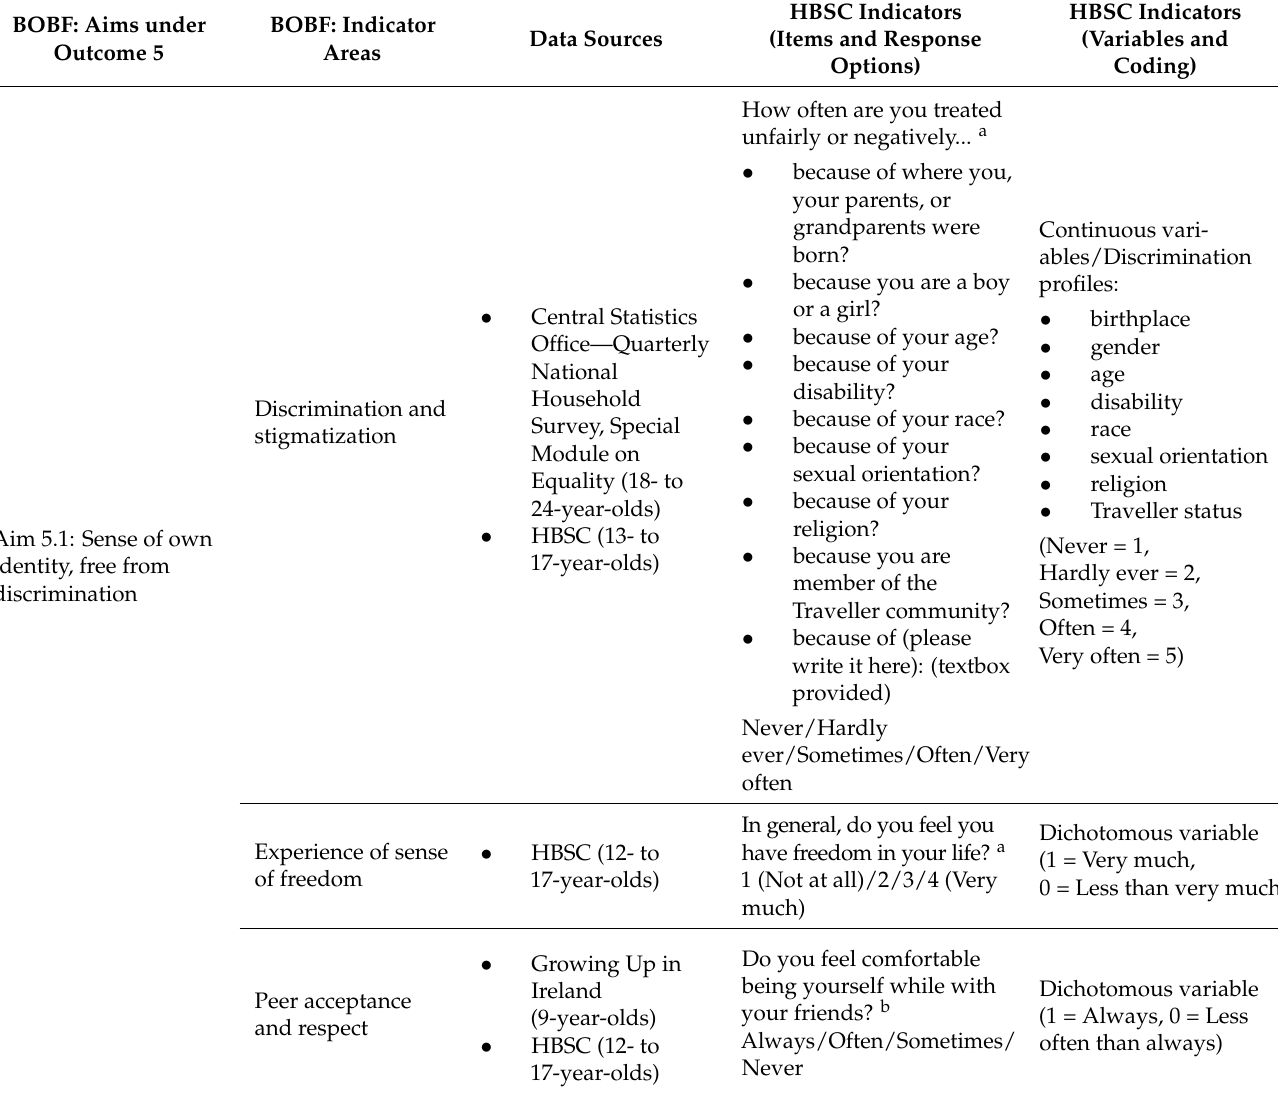
Table 1. Better Outcomes, Brighter Futures (BOBF) framework Outcome 5: “Connected, respected, and contributing to their own world”—Aims and indicator areas within the framework and indicators/response options within the Health Behaviour in School-aged Children (HBSC) Ireland